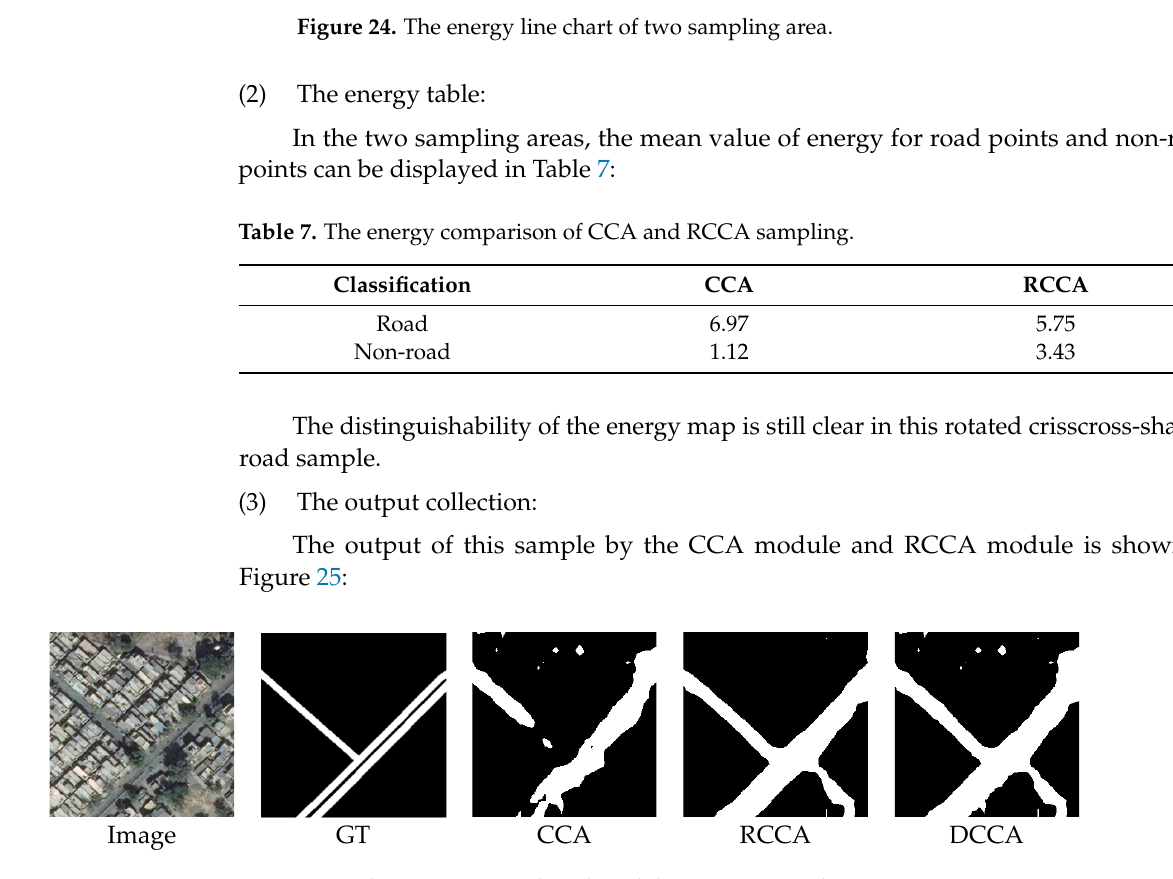
Figure 24. The energy line chart of two sampling area.